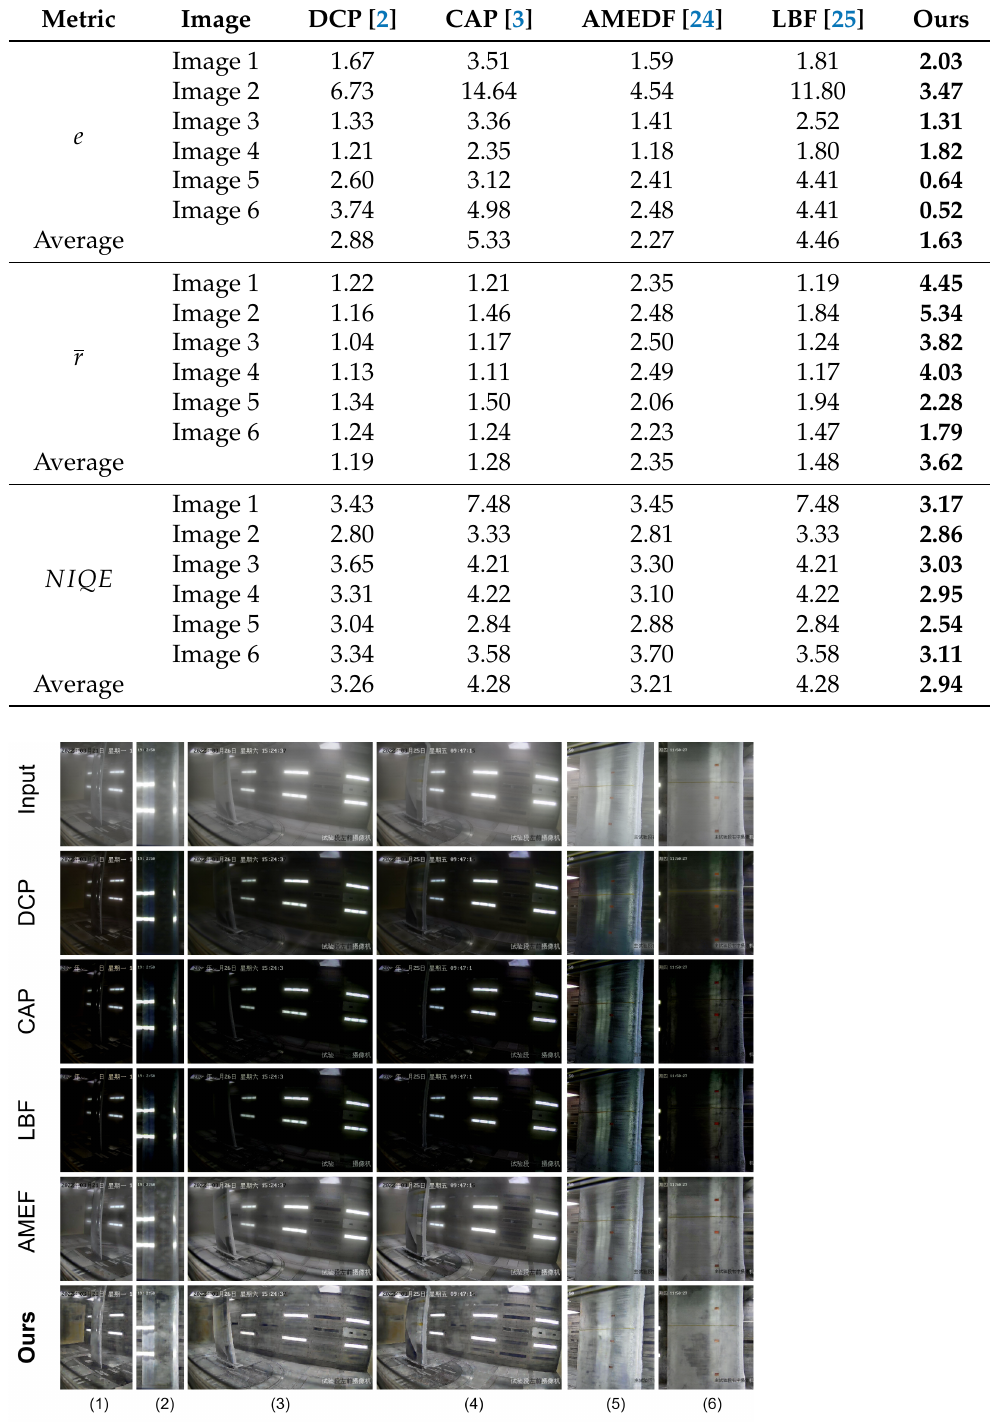
Figure 6. Comparison of six real foggy images in an icing wind tunnel with existing traditional methods. ( 1 , 2 ) LWC = 1.31; ( 3 , 4 ) LWC = 1.0; ( 5 , 6 ) LWC =